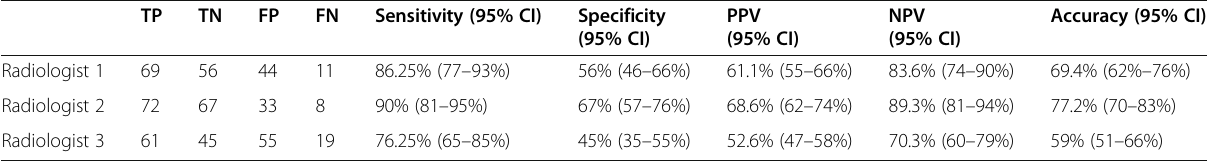
Table 3 Performance results of the three radiologists for differentiation between COVID-19- and non-COVID-19-associated GGO